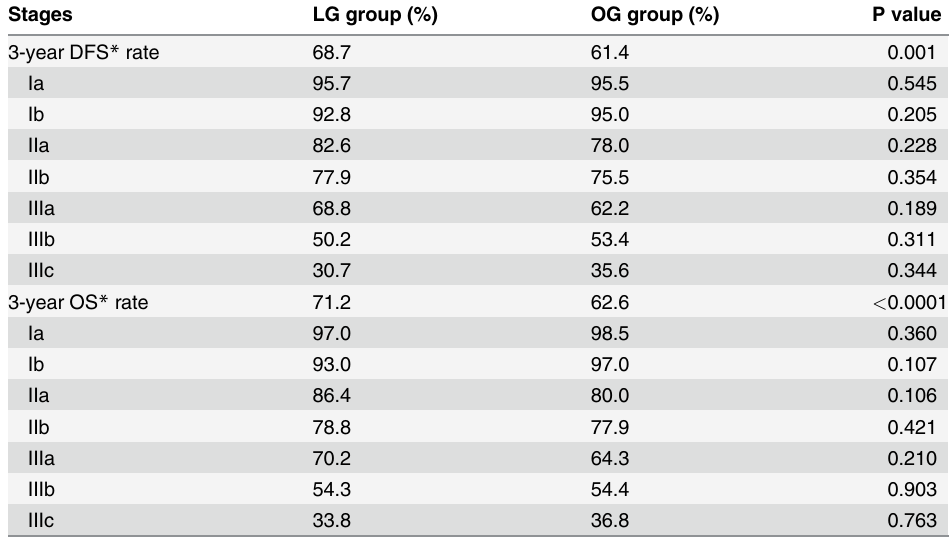
Table 4. The calculated 3-year DFS rates and OS rates after laparoscopic and open